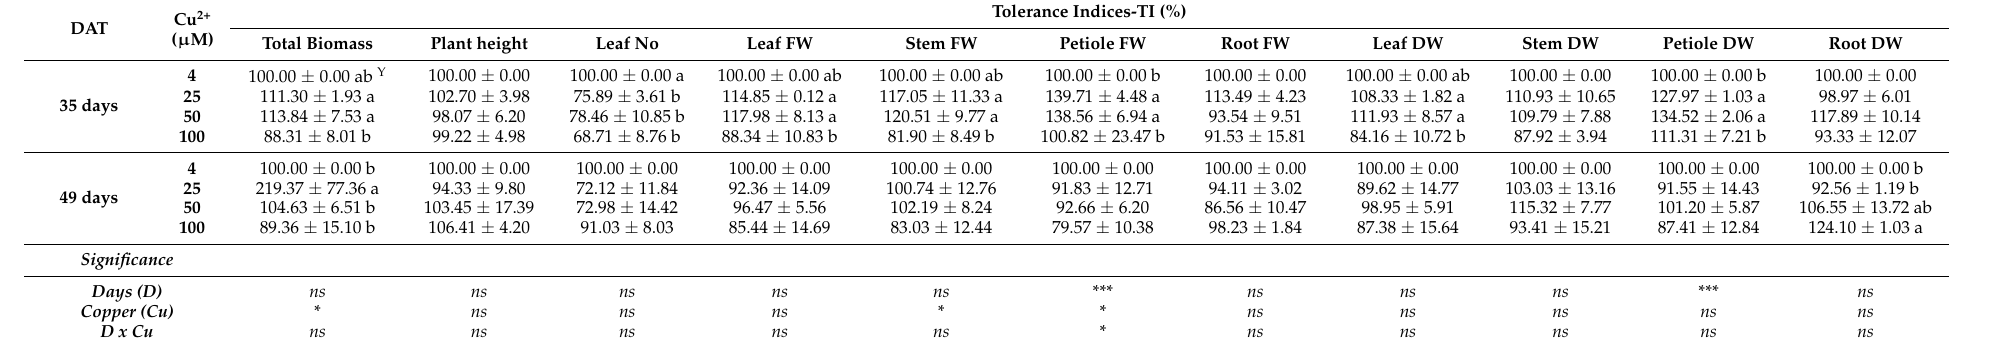
Table 4. Tolerance indices (TI (%)) for Cu after 35 and 49 DAT in pelargonium plants grown hydroponically in